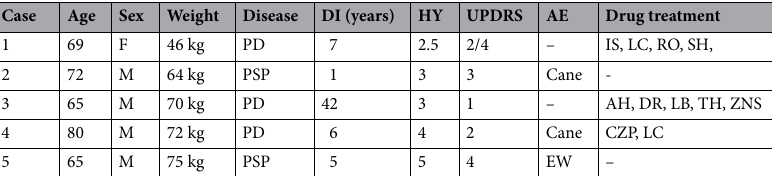
Table 1. Summary of participant physical and clinical characteristics. AE usage of assistive equipment in daily life, AH amantadine hydrochloride, CZP clonazepam, DI duration of illness, DR droxidopa, EW electric wheelchair, F female, FG festinating gait, FOG freezing of gait, GD gait disturbance, HY Modified Hoehn and Yahr Scale, IS istradefylline, LB levodopa-benserazide, LC levodopa-carbidopa, M male, PD Parkinson’s disease, PSP progressive supranuclear palsy–pure akinesia with gait freezing, RO rotigotine, SG staggering gait, SH selegiline hydrochloride, SSG small stepping gait, TH trihexyphenidyl hydrochloride, UPDRS Unified Parkinson’s Disease Rating Scale, item 14 (freezing of gait), ZNS